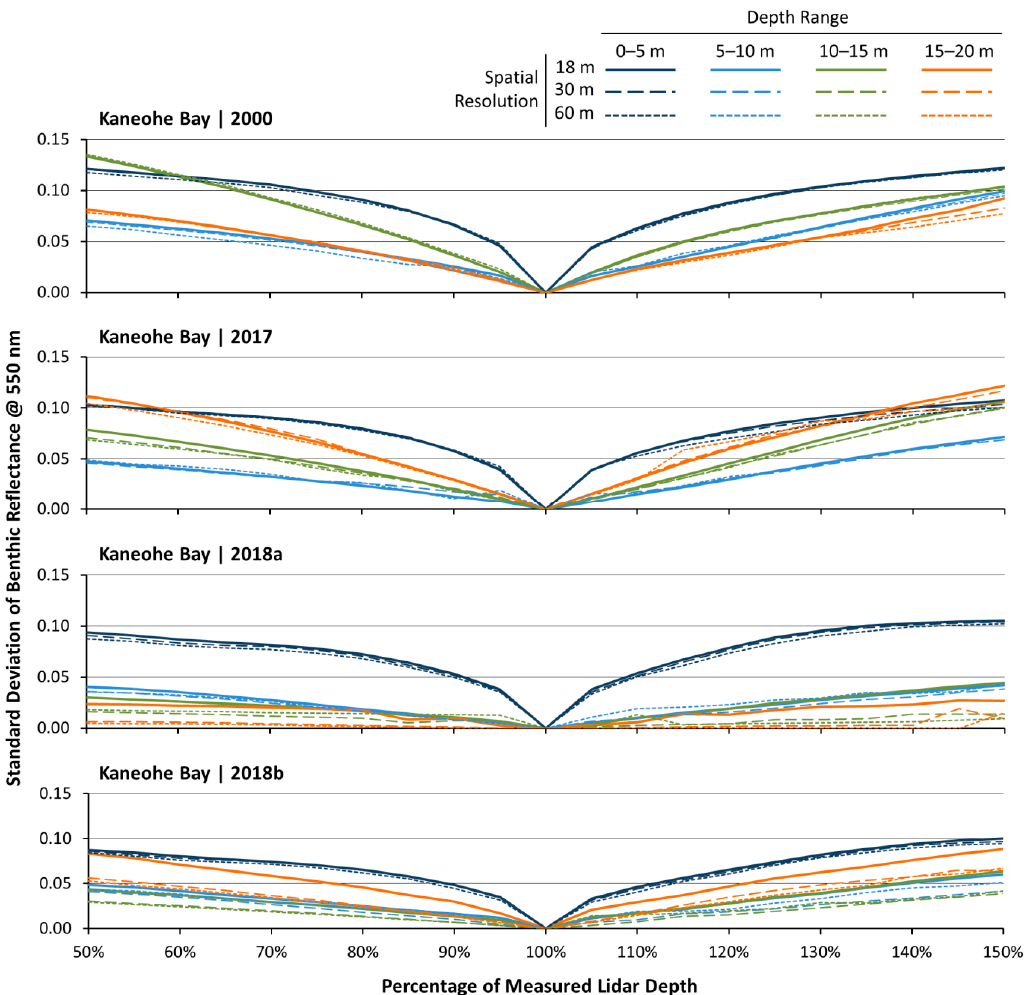
Figure 9. Sensitivity analysis of derived benthic reflectance at 550 nm for Kaneohe Bay AVIRIS-C data at 18, 30, and 60 m spatial resolution; illustrating differences in standard deviation of derived reflectance as a function of variations in water depth.